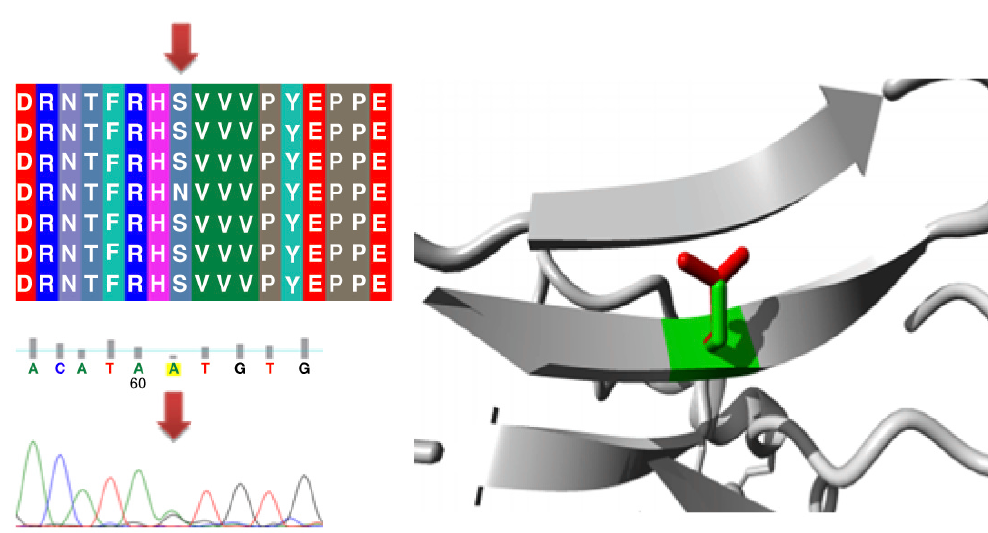
Figure 4. Mutation of a serine into asparagine at position 215.